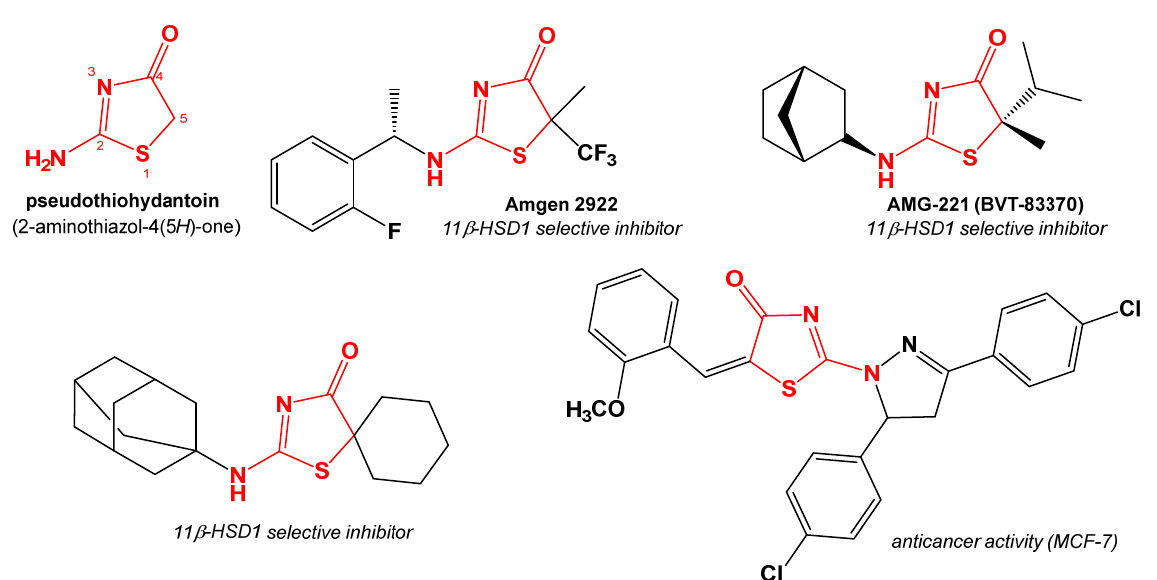
Figure 1. Structures of selected biologically active pseudothiohydantoin derivatives.